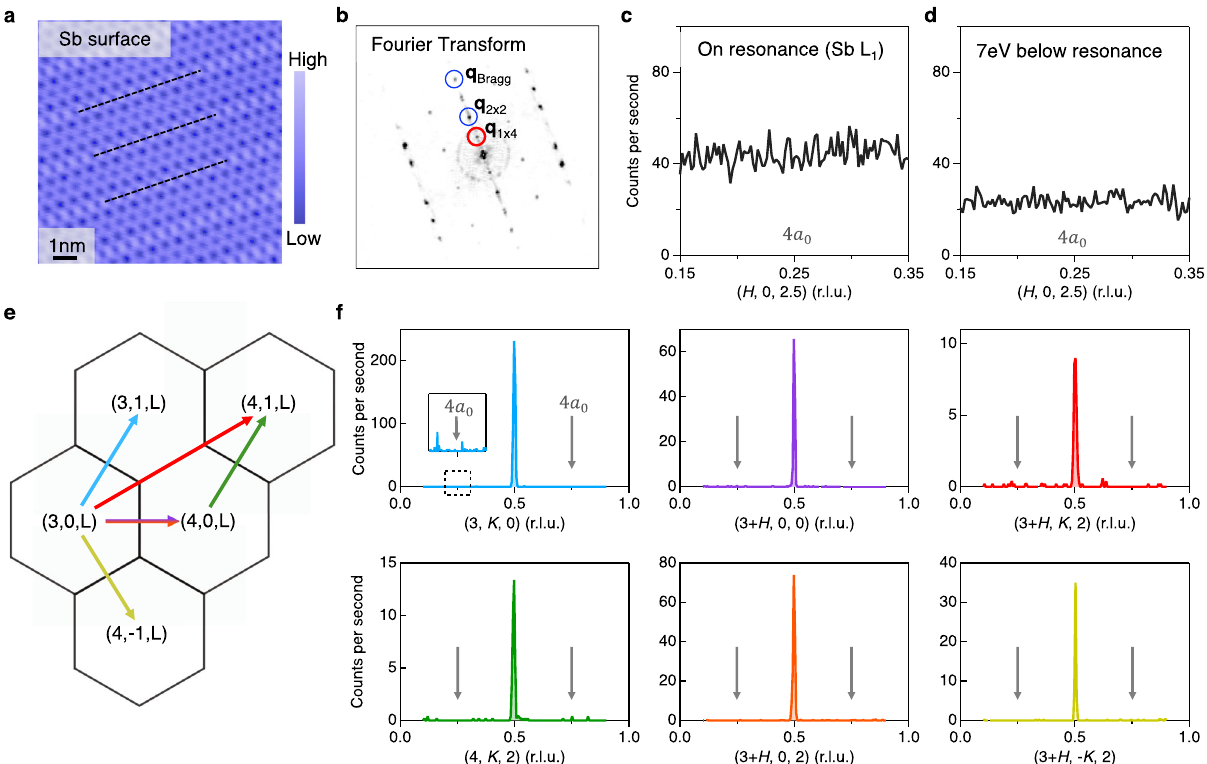
e Schematics indicating the scattering trajectories for scans shown in f . meV- resolution hard X-raydiffraction measurementsshown in f were performed at10K and covered all in-plane high symmetry directions with zero and fi nite L compo- nents. The bulk CDW peaks can be clearly resolved in all scans in f , but there is no peakfeatureat q =0.25in neither the resonancemeasurements ( c , d ) nor the high- precision hard X-ray measurement ( f